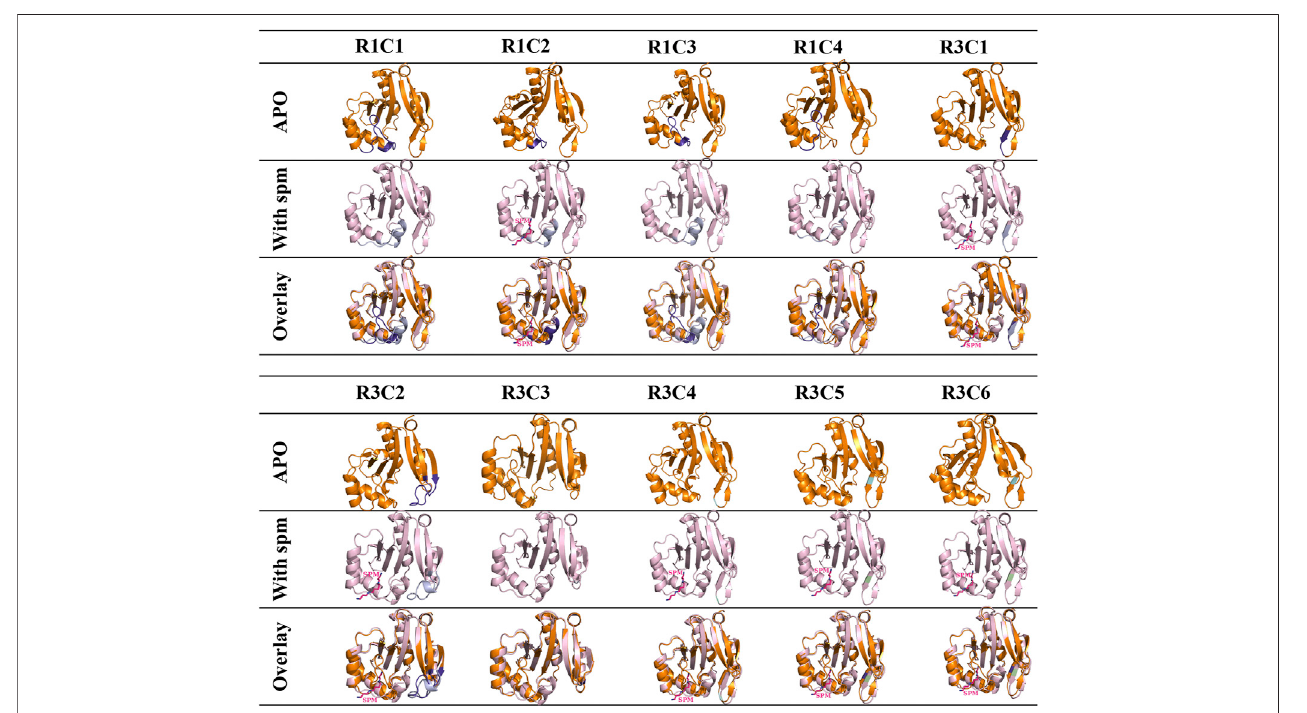
FIGURE5| Analysisofapoandspm-boundhomologymodelsof10VcSpeGconstructs.HomologymodelsofallconstructsweregeneratedusingSwissmodelto obtain apo- and spm-bound models since some proteins did not crystallize. Apo-homology models are in orange ribbon diagrams and the WT-apo structure (PDB ID: 4jjx)wasused asthetemplate. Thespm-boundhomologymodelsareinlightpinkandwerebasedontheWTwithspm-bound structure (PDBID: 4mi4)asthetemplate. Substitutionsareshowninpurplefortheapomodelsandvioletforthespm-boundmodels.Lightgreenindicatesthelocationofapointmutationandspmisshown as pink sticks. Spm was present in the R1C2, R3C1, R3C2, R3C4, R3C5, and R3C6